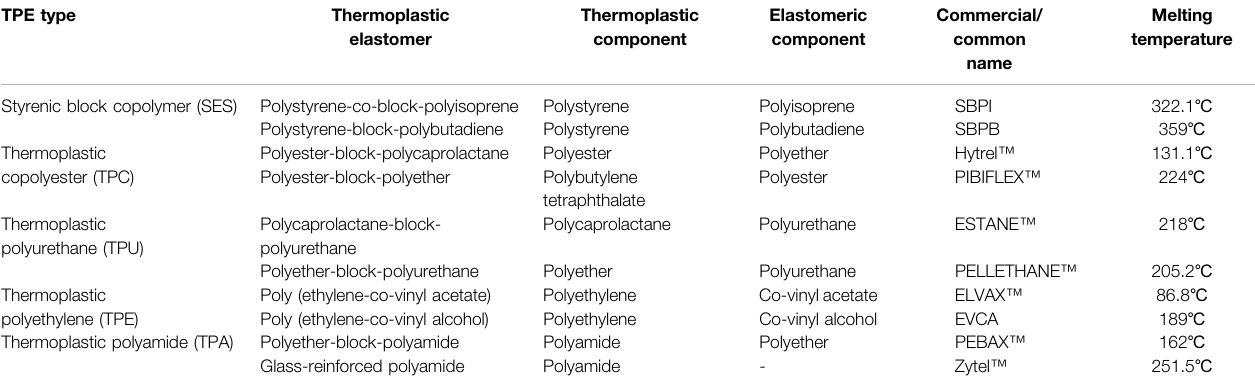
TABLE 1 | List of materials studied. Thermoplastic elastomers (TPEs) tested, their classi fi cation, composition and common name, and melting temperature at ambient pressure and temperature obtained from DSC